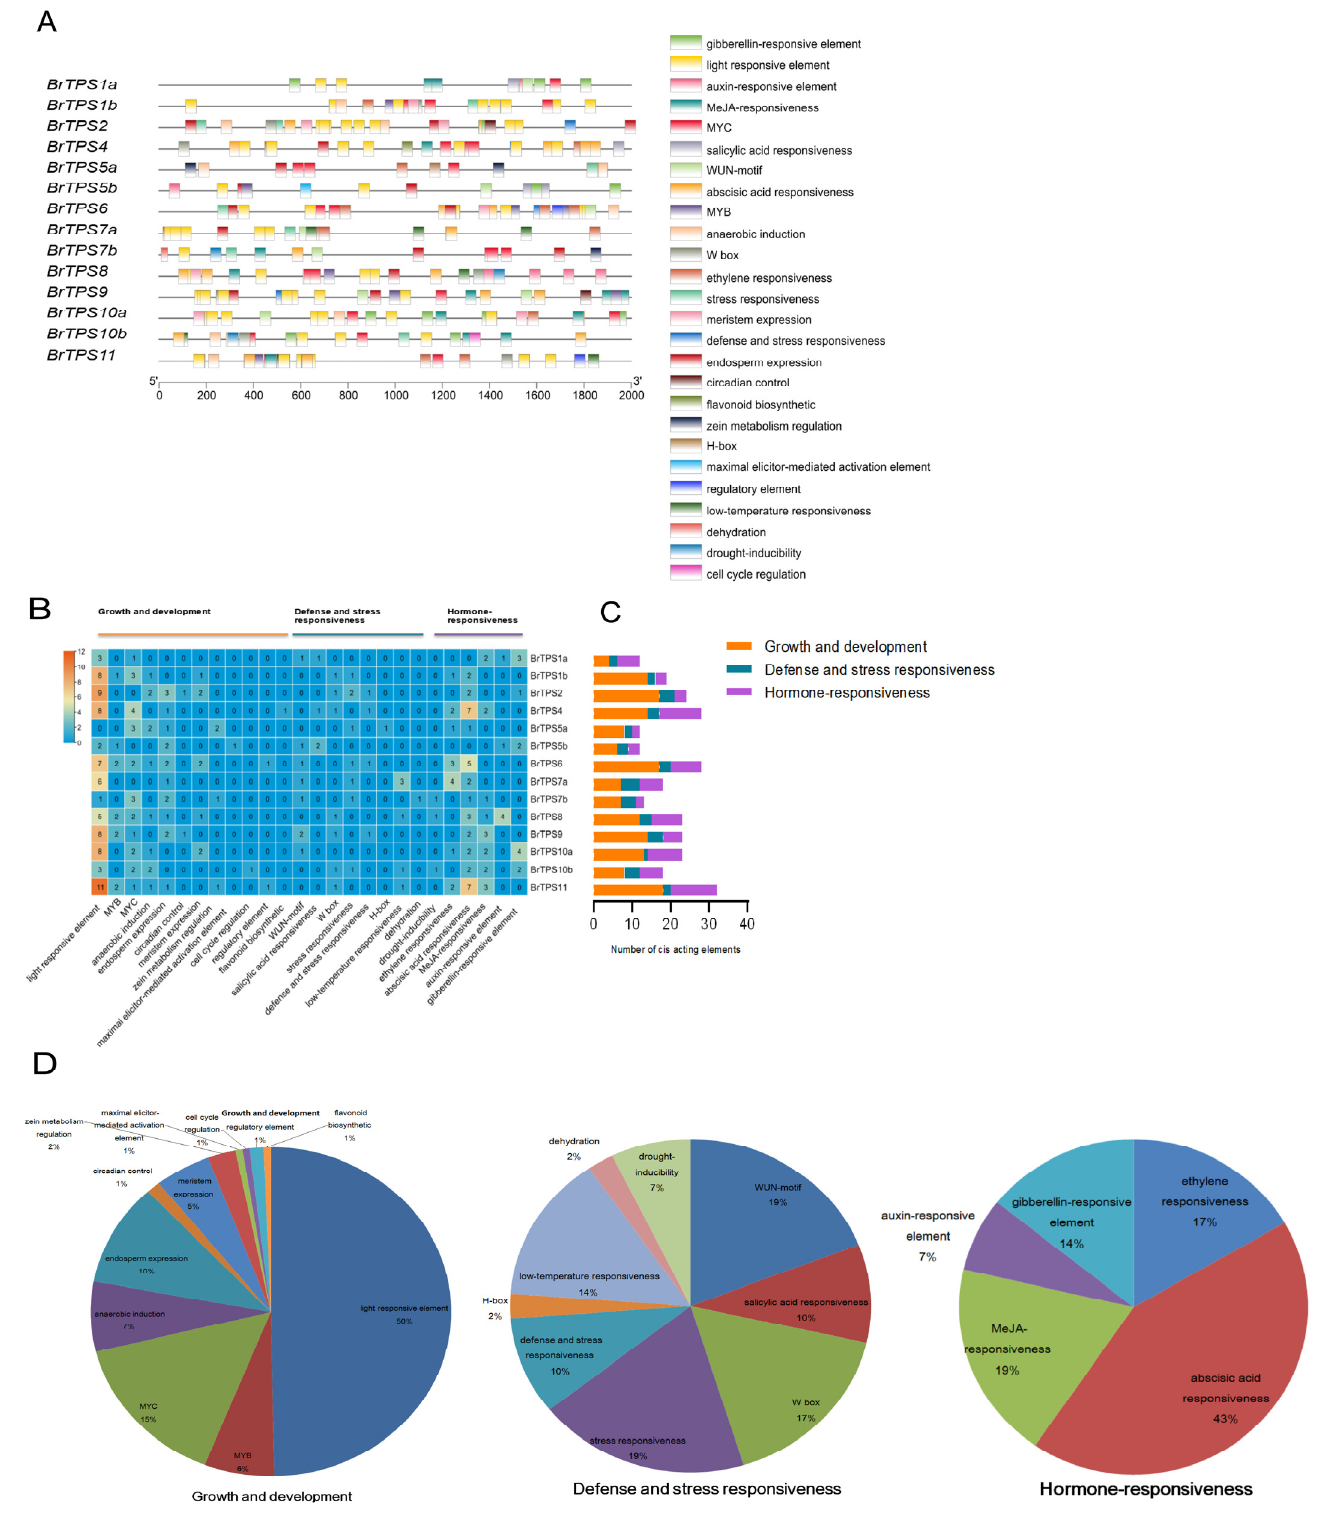
Figure 6. Predicted cis-elements in BrTPS gene promoters. Promoter sequences (2000 bp) of 14 BrTPS genes were analyzed using the PlantCARE database. ( A ) Kind and position of cis-acting elements in BrTPSs . ( B ) numbers of cis-acting elements. The gradient blue colors and numbers in the grid indicate the number of different cis-acting elements in BrTPSs . ( C ) Number of cis-acting elements in 14 BrTPS genes containing three category; histograms with different colors represent different categories. ( D ) Proportion of different cis-acting elements in each category.